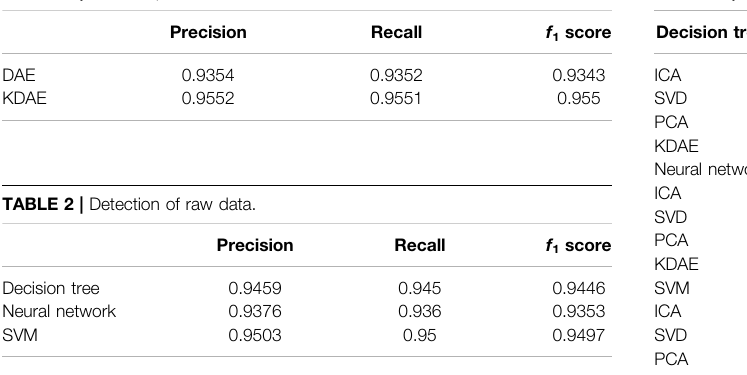
TABLE 4 | Detect data in 22 dimensions. TABLE 1 | The comparison of feature extraction abilities.